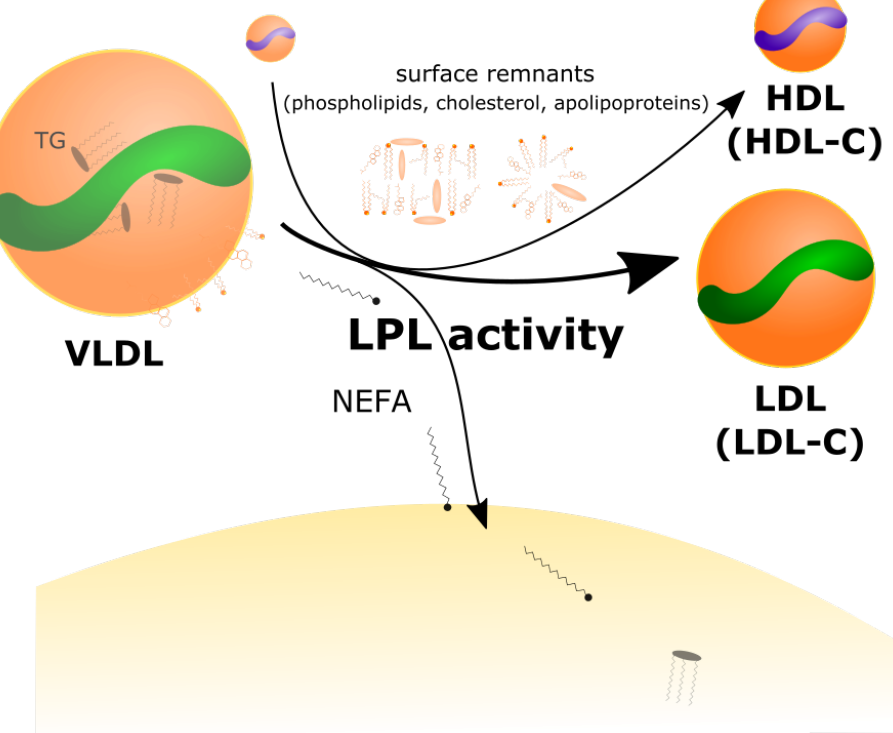
Figure 2. Lipoprotein lipase-mediated increase in LDL-C and HDL-C. In the presence of increased VLDL synthesis and secretion, lipoprotein lipase (LPL) activity liberates non-esterified fatty acids (NEFAs) for adipocytes and oxidative tissues. As TGs are lipolyzed, VLDLs shrink with loss of surface remnants (including cholesterol, phospholipids, and apolipoproteins) to HDL acceptor particles, and subsequent catabolism to LDL, resulting in increases in LDL particle mass, LDL-C, HDL particle mass and